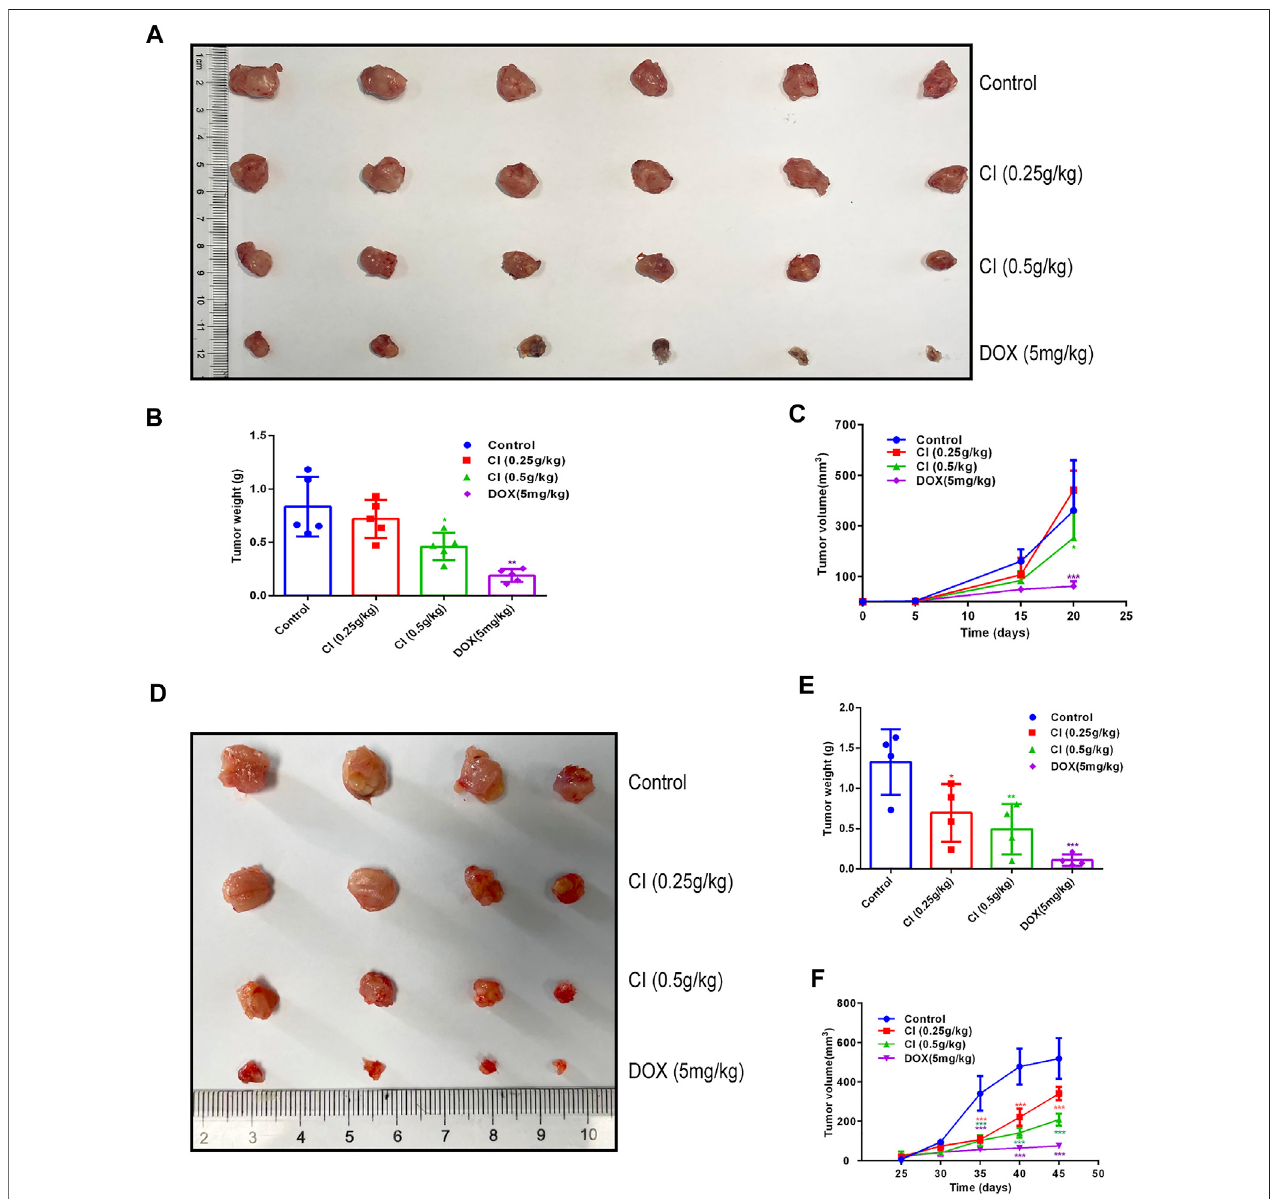
FIGURE3| CIinhibitsgrowthanddevelopmentinthemousemodelofTNBC(dataofA,B,andCfrom4T1tumor-bearingmiceanddataofD,E,andFfromMDA- MB-231 tumor-bearing mice). (A) Tumor tissues after sacri fi ce. (B) Tumor weight after CI treatment or DOX. (C) Tumor volume growth curve after CI treatment or DOX. (D) Tumor tissues after sacri fi ce. (E) Tumor weight after CI treatment or DOX. (F) Tumor volume growth curve after CI treatment or DOX. * p < 0.05, ** p < 0.01, *** p < 0.001 vs. control.